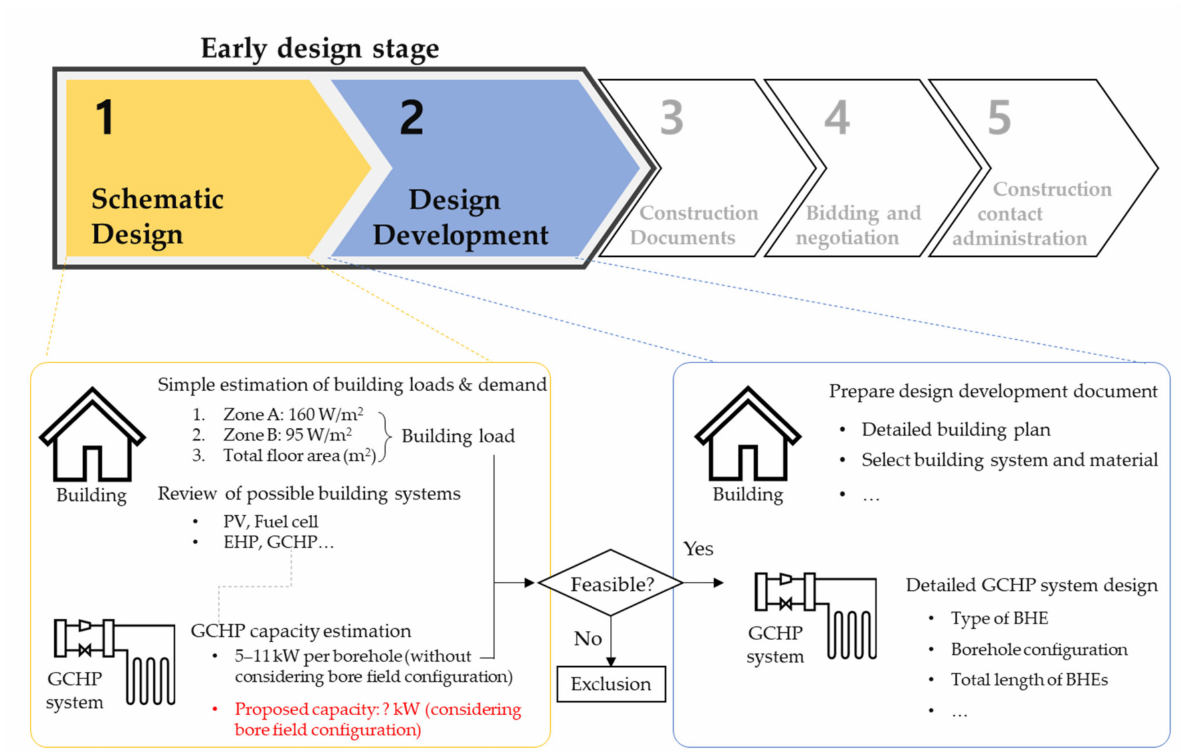
Figure 1. The five main stages of a construction project and the ground-coupled heat pump system (GCHP) design process in the early